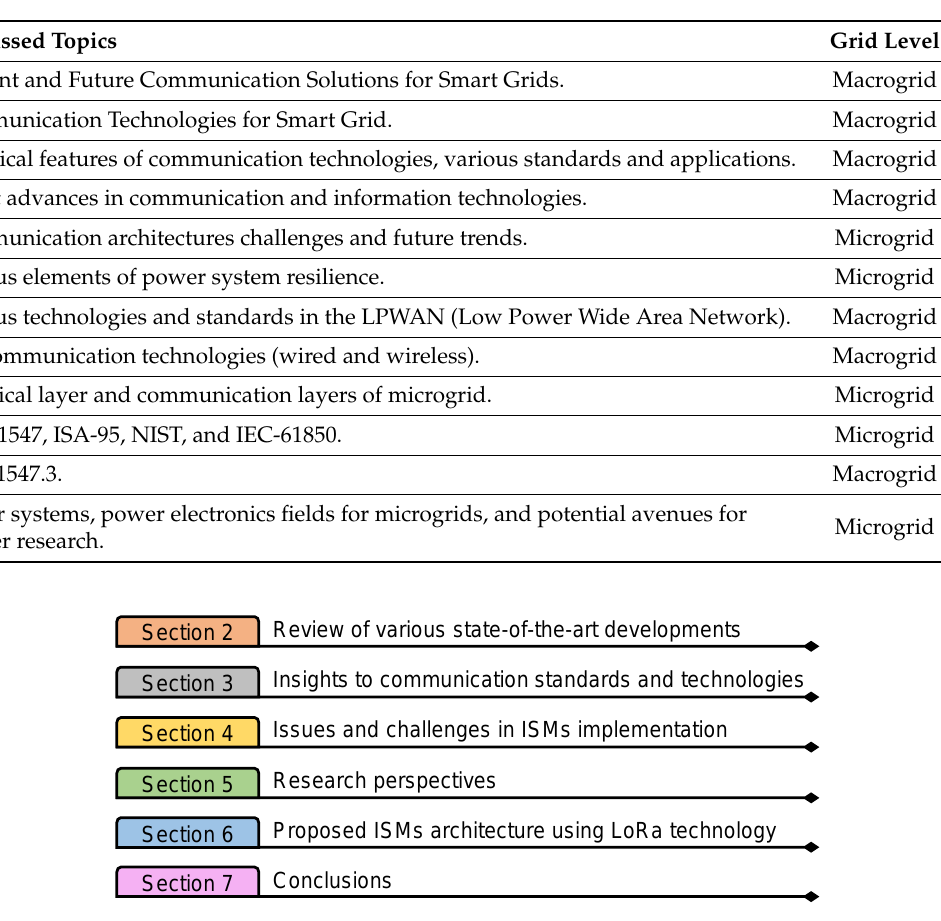
Table 1. Summary of review works presented in the literature.